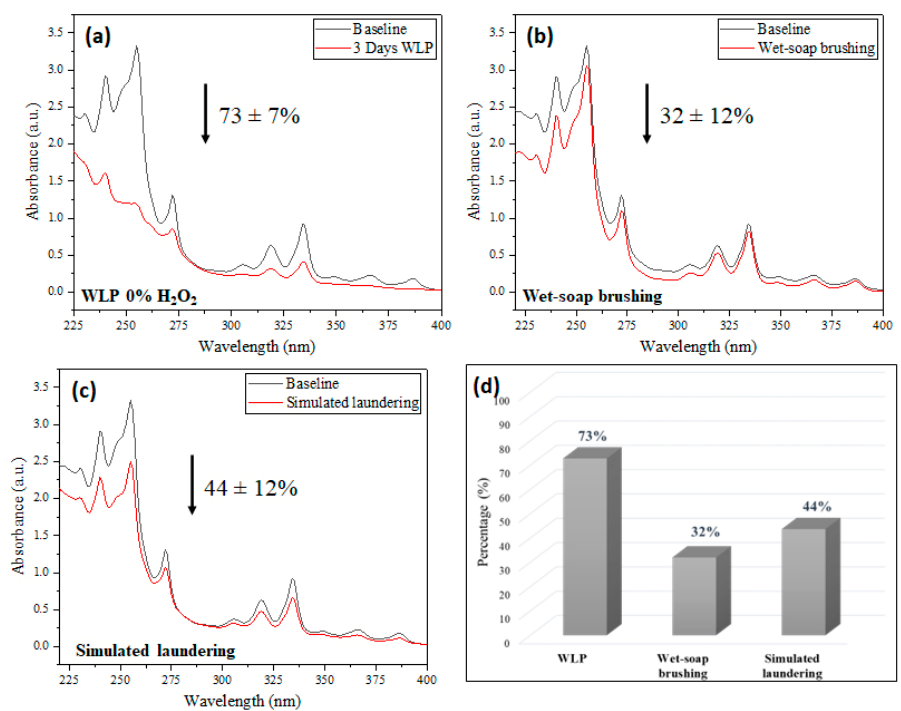
Figure 9. UV/VIS spectra of decontamination procedure performed by ( a ) WLP for 3 days without H 2 O 2 ; ( b ) simulated laundering; and ( c ) wet-soap brushing. ( d ) Summary of percentage of PAHs removal.